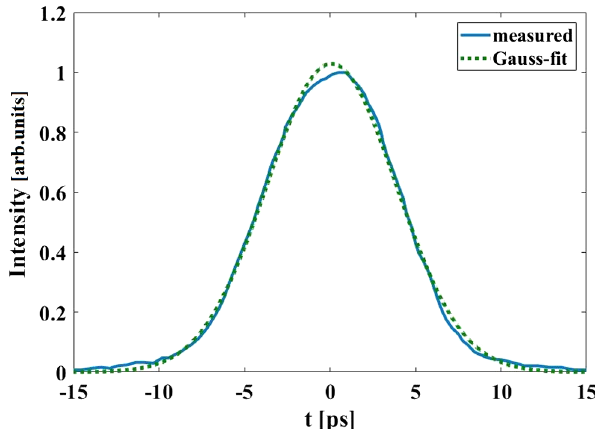
FIG. 3. A measured temporal profile of the cathode drive laser pulse